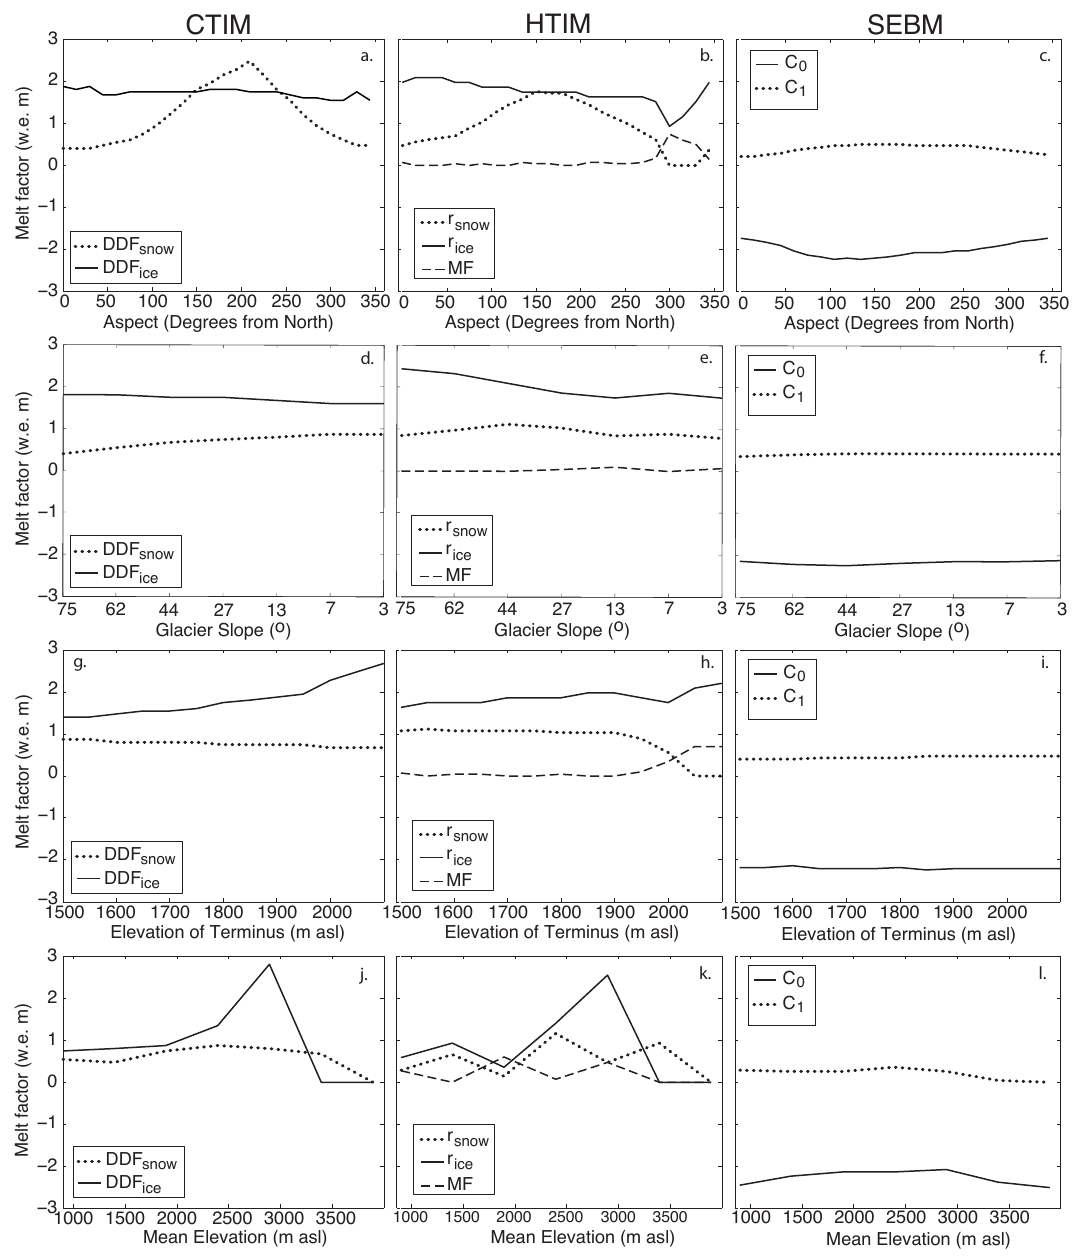
Fig. 4. Melt-model parameter sensitivity to glacier aspect (first row), surface slope (second row) and minimum (third row) and mean (fourth row) elevation. Minimum elevation and glacier length are manipulated together in order to preserve glacier slope. For the mean elevation test, initial snow depth is held constant. Note the tangential scale for